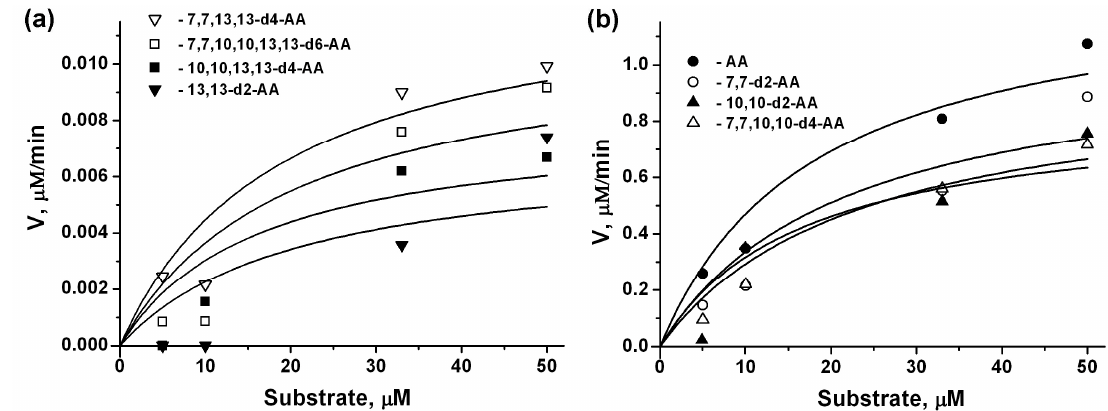
Figure 2. Steady state kinetics of 15-LOX-2 with arachidonic acid (AA) and deuterated arachidonic acids. ( a ) 13,13-d2-AA; 7,7,13,13-d4-AA; 10,10,13,13-d4-AA; 7,7,10,10,13,13-d6-AA; ( b ) AA, 7,7-d2-AA; 10,10-d2-AA; 7,7,10,10-d2-AA. Details are described in Experimental Procedures. All experiments were conducted in triplicate. Standard deviations are indicated in Table 1.